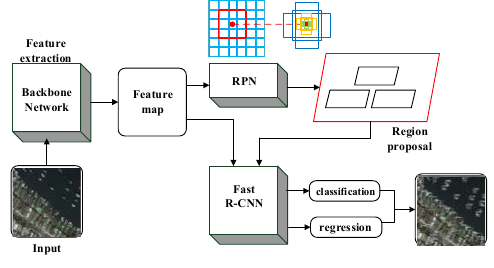
Figure.3 multi-feature